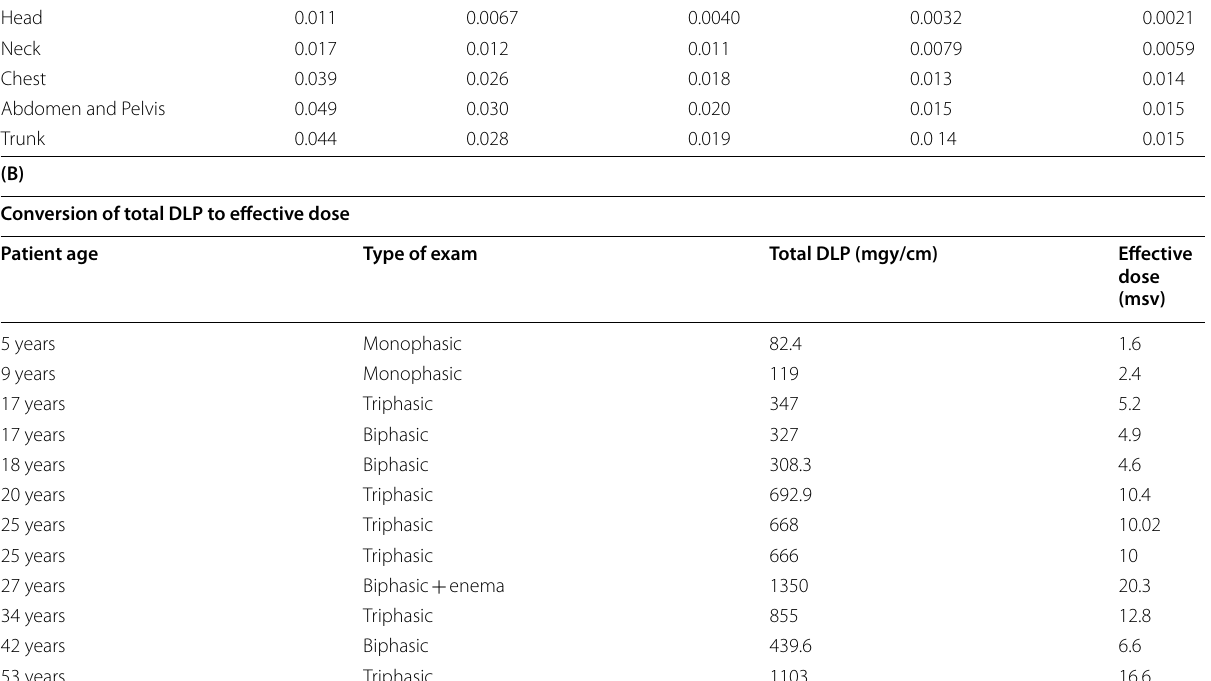
NB. Table 1B shows representative group of our patients, conversion of Total DLP to Effective dose, through multiplication by K-factors tissue weighting considering age (according to Table